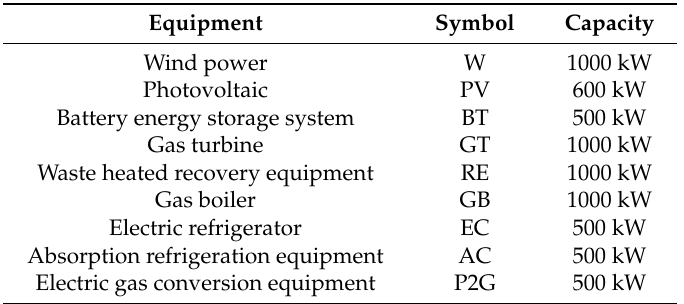
Table 1. The equipment parameters of the integrated energy system.